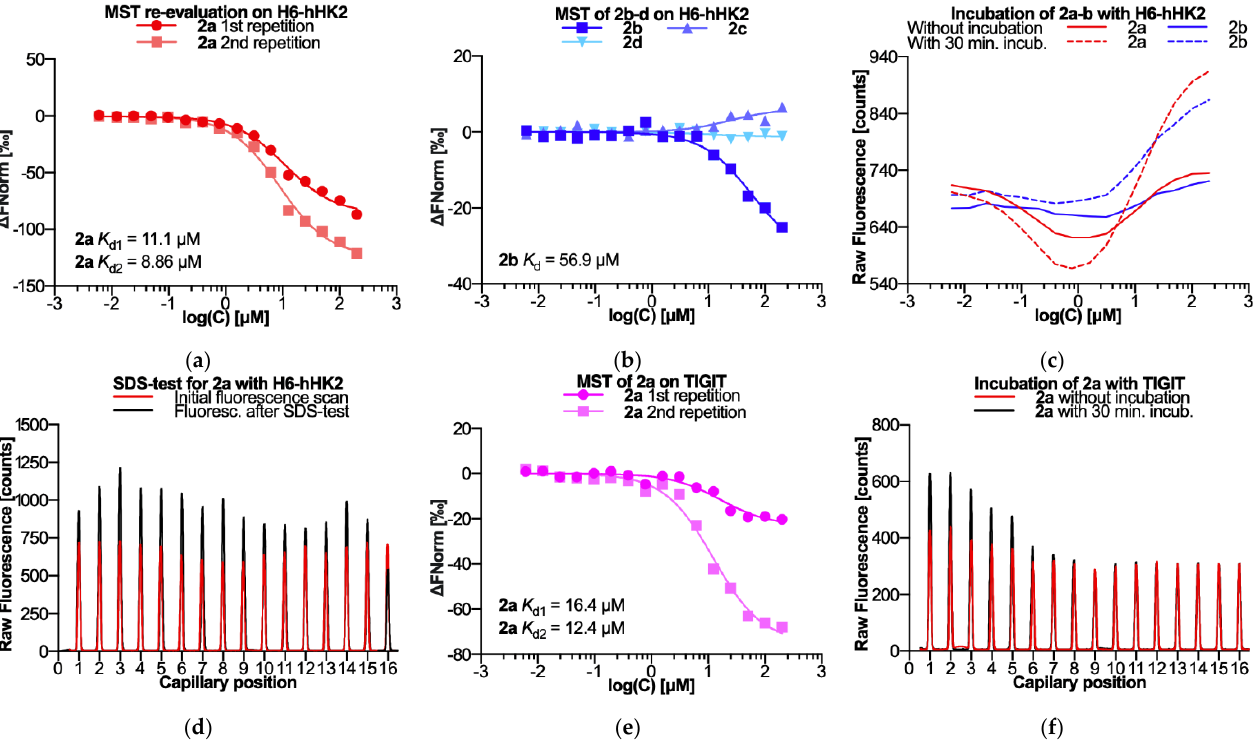
Figure 1. Evaluation of the binding affinity of ( a ) 2a and ( b ) 2b – 2d to H6-hHK2. ( c ) Increasing trend profiles observed in initial capillary fluorescence before and after 30 min of H6-hHK2 incubation with 2a and 2b . ( d ) Initial capillary fluorescence before and after the 2a SDS-test with H6-hHK2. ( e ) Evaluation of the binding affinity of 2a to TIGIT. K d values were automatically calculated by curve fitting and presented as mean. ( f ) Initial capillary fluorescence before and after 30 min incubation of TIGIT with 2a . Capillaries have decreasing ligand concentration from left to right in serial 2-fold dilutions ranging from 200 to 0.006 μ M.